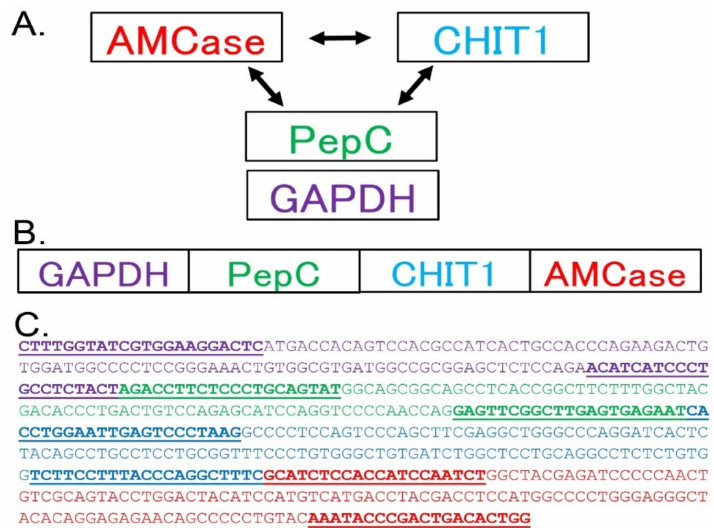
Figure 1. Strategy for the comparison of the gene expression levels of four crab-eating monkey genes. ( A ) We compared the expression levels of the acidic mammalian chitinase (AMCase ) and chitotriosidase ( CHIT1 ) genes. To evaluate chitinase levels in various monkey tissues, we used glyceraldehyde-3-phosphate dehydrogenase (GAPDH) and pepsinogen C ( Pep C ) as reference genes ( Pep C only for stomach) in the same scale by using our quantitative reverse transcriptase-coupled PCR (qPCR) system. ( B ) Schematic representation of the standard DNA used for the qPCR. The target fragments for GAPDH , pepsinogen C , CHIT1 , and AMCase complementaries DNA (cDNAs) were combined at a one-to-one ratio in a single DNA fragment. ( C ) Nucleotide sequence of the standard DNA containing four cDNA fragments (shown in different colors) covering the PCR target